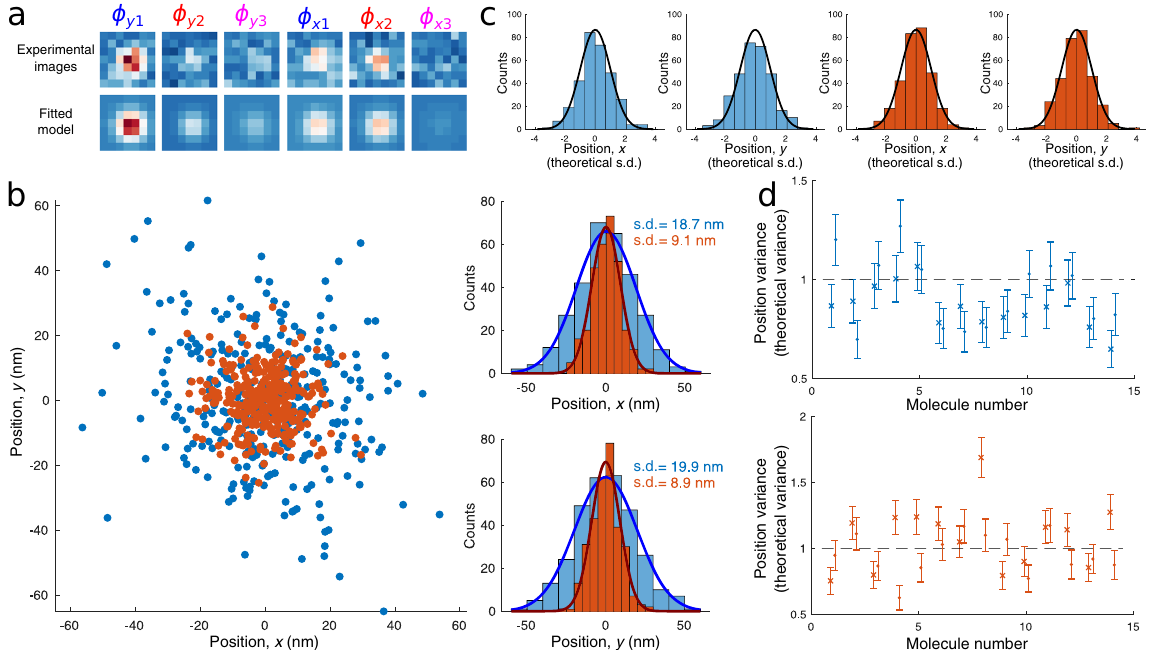
Fig. 3 Experimental demonstration of C-MELM for localization of single molecules. a Single Atto590-labeled Streptavidin molecules were subjected to six 50-ms exposures of structured illumination: three phases of, respectively, y -periodic ( ϕ y ) and x -periodic illumination ( ϕ x ). Each molecule thus produced six diffraction-limited images (top row), which constitute one measurement. The molecule ’ s position and six spot intensities were estimated by a simultaneous maximum likelihood estimation fi t of six model point-spread functions (PSFs) with shared point-source location, in which we constrained the relative intensities in spots as expected from the illumination structures (bottom row, Methods). For display, each image was averaged over ten frames for noise-reduction, but all position estimates obtained below were done on individual frames. The effective pixel size was 107 nm. b 310 positions of the molecule in a obtained, respectively, by PSF- fi tting (blue) and C-MELM (orange). The estimates are centered on their respective mean values. Position estimates for each coordinate and localization method are normally distributed yielding a localization precision as given by the s.d. in the legend. c Histograms of all position estimates for PSF- fi tting (blue) and C-MELM (orange) centered on their mean values and in units of their theoretically predicted s.d. calculated from the Cramér-Rao lower bound (CRLB). Agreement with a standard normal distribution with unit variance (black curve) demonstrates that localization in each case is optimal. d Sample variances of x - (crosses) and y -coordinates (circles) of positions obtained, respectively, with PSF- fi tting (blue) and the C-MELM (orange) for 14 isolated single molecules in the fi eld of view in units of their respective theoretical variance (calculated from the CRLB). The data fl uctuate around 1, which is expected when estimates achieve the theoretical limit for performance, the CRLB. Error bars indicate the s.d. of the sample